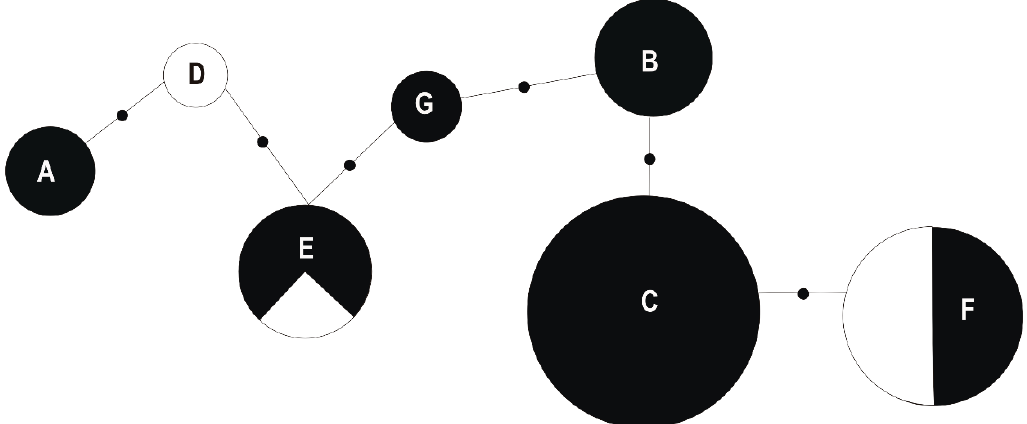
Figure 4. Minimum spanning tree (MST) based on a pairwise distance matrix computed on the basis of 900-bp 16S rRNA gene sequence analysis of studied genotypes (symbols A–G) of Bacillus megaterium strains derived from the Bolesław, Saturn, and Bukowno waste heaps (metalliferous) and Bolestraszyce non-polluted reference (non-metalliferous) area. The size of the circle corresponds to the genotype frequency. Small dots on the tree edges correspond to the number of nucleotide differences in 900-bp 16S rRNA gene between nodes representing B. megaterium genotypes (A–G). Dark parts of the circles correspond to the frequency of B. megaterium strains with a given genotype in a metalliferous area.